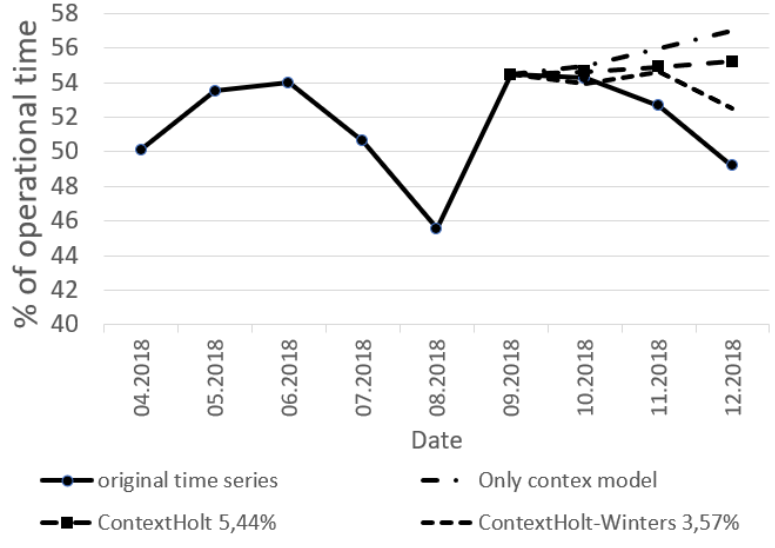
Figure 8. Forecast of % of the operational time of the department with use of contextual